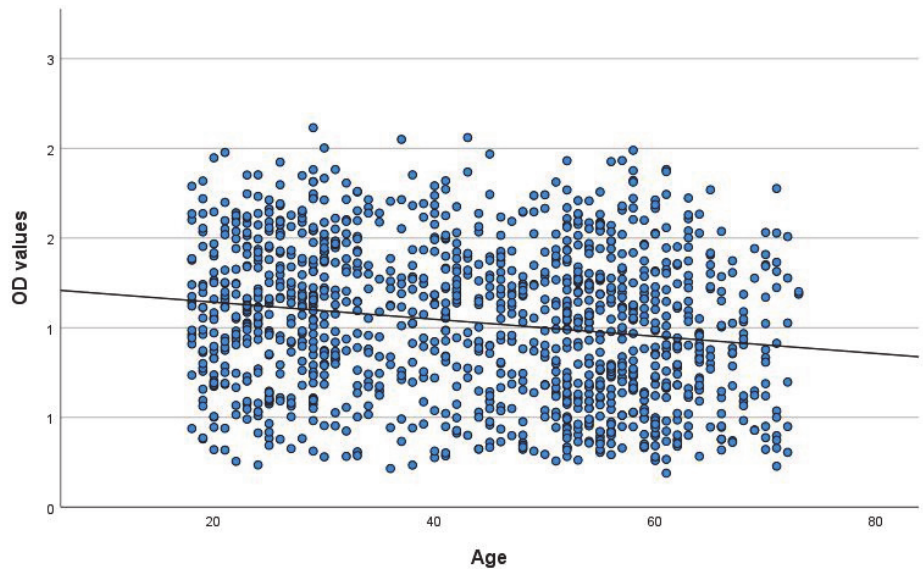
Figure 3. A linear regression model (line) was applied to analyse the relationship between OD val- ues (scatter diagram) and age. There is a declining trend in OD values with increasing age.